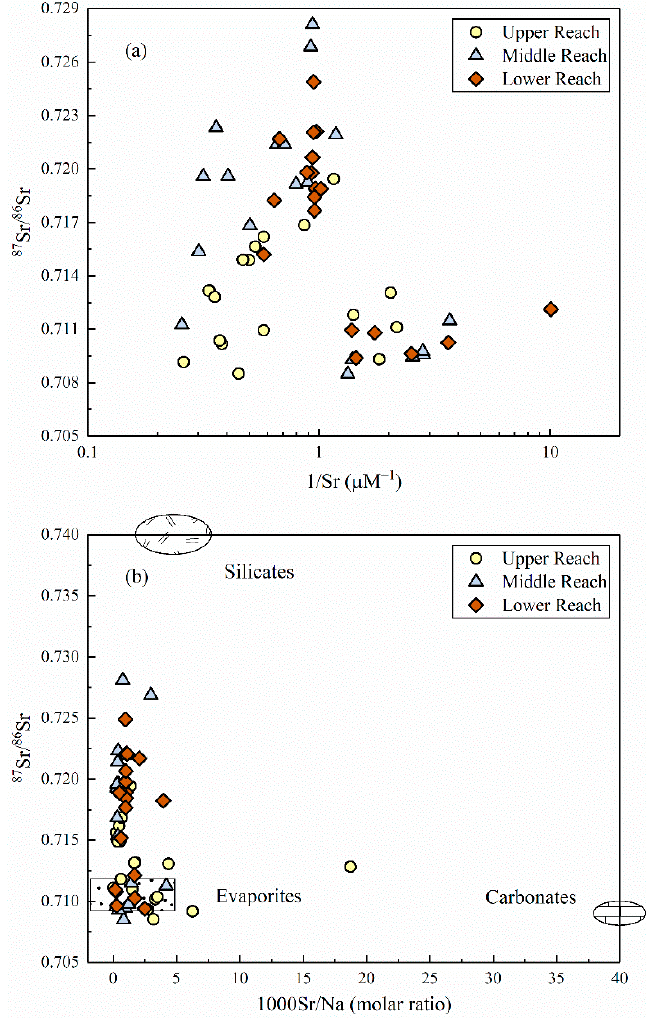
Figure 7. ( a ) 87 Sr/ 86 Sr ratios versus 1/Sr ( b ) 87 Sr/ 86 Sr ratios versus 1000Sr/Na molar ratios in the MRB. Data of the end-members (evaporites, silicates and carbonates) were referred from [47] .